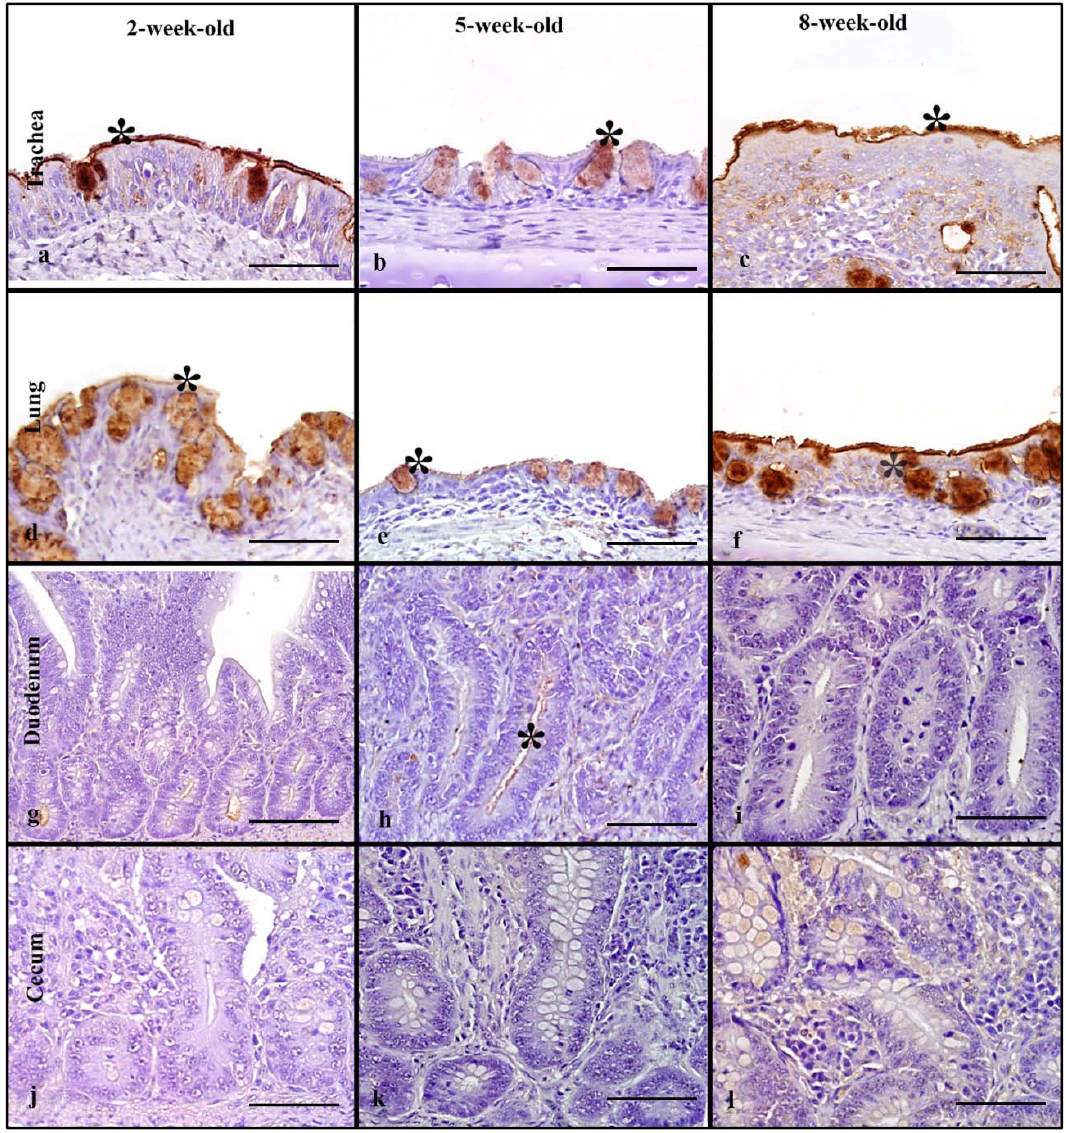
Figure 2. HPAIV H5 rHA binding in Muscovy ducks of different age groups, visible as dark brown staining using 3,3- diaminobenzimidine (DAB) HRP via protein histochemistry denoted by asterisk (*). Strong and very strong levels of rHA bindngi is seen in trachea of 2- and 8-week-old Muscovy ducks ( a , b ). Note very strong levels of binding in the lung of 2- and 8-week-old Muscovy ducks ( d , f ). Minimal to mild rHA binding is seen in the intestinal tract of Muscovy ducks ( g – l ). Scale bar is 50 µm.